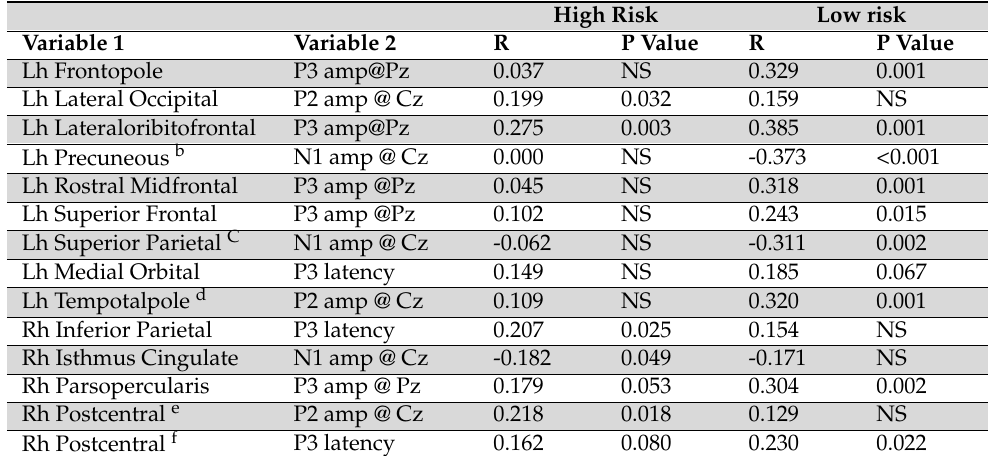
Table 4. FreeSurfer regions associated with ERP components recorded at a point closest to the MRI scan a